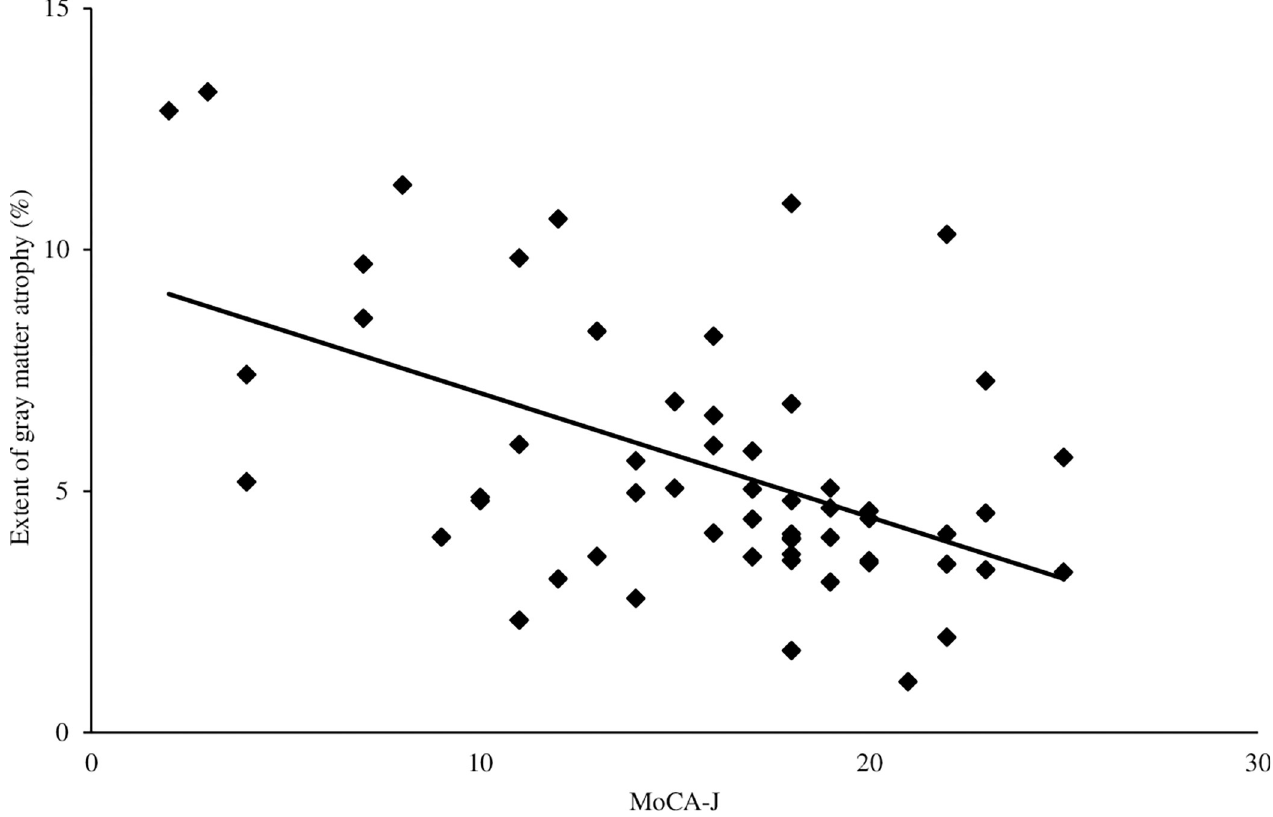
Fig 4. Relationship between the VSRAD analysis index and MoCA-J. The vertical axis indicates the VSRAD analysis index, and the horizontal axis indicates the MoCA-J scores. The extent of gray matter atrophy was r = -0.52 and p < 0.001.